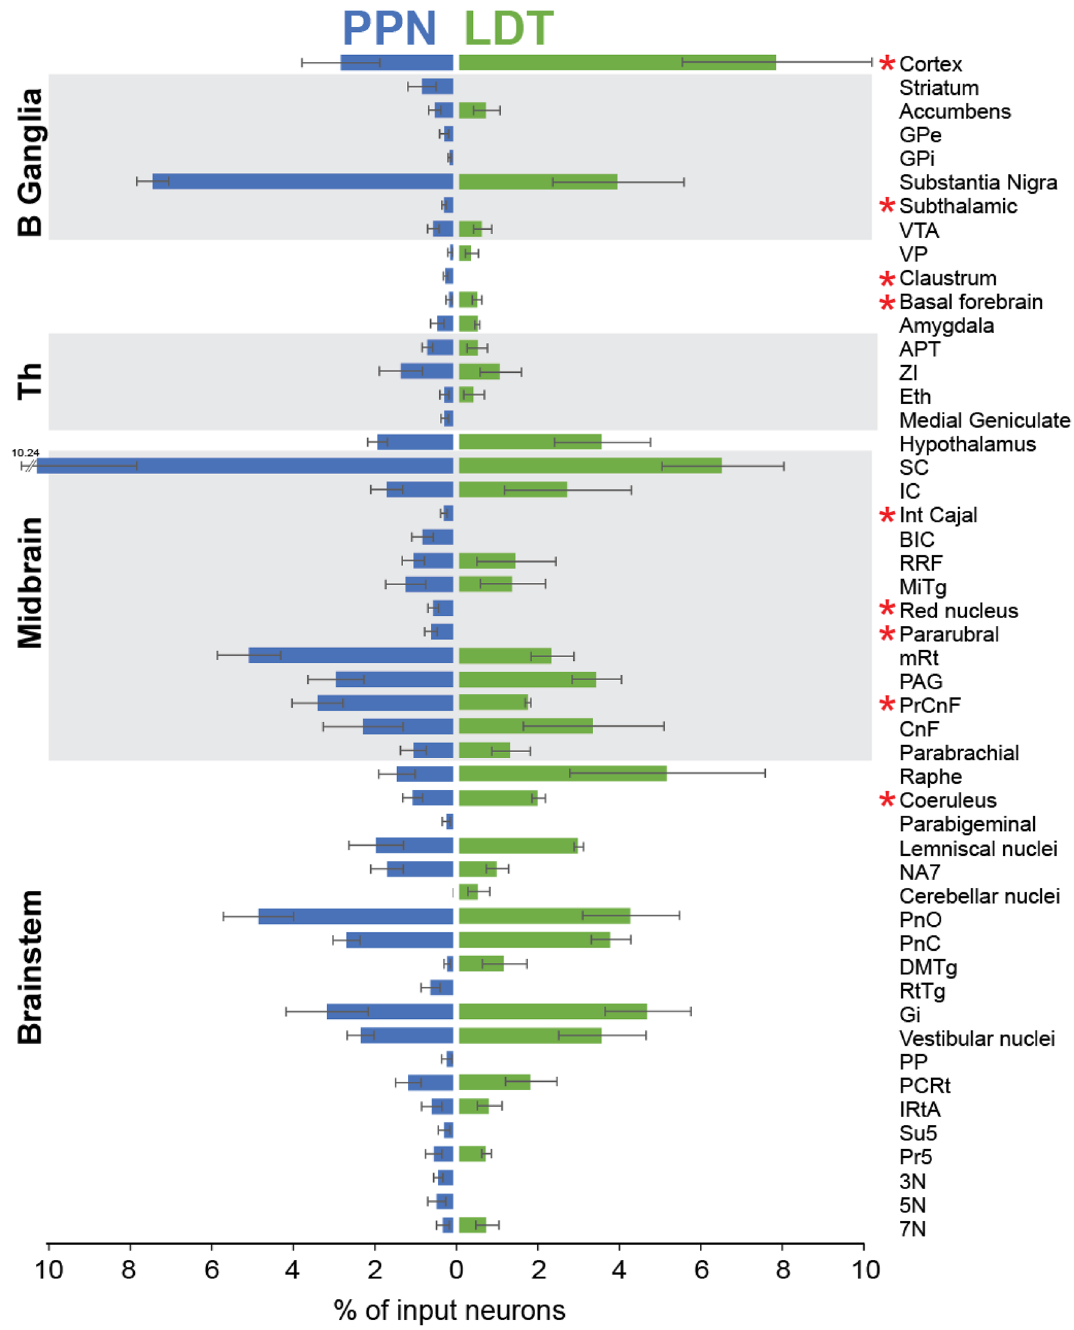
Figure 3. Major input structures to the cholinergic neurons of the PPN and LDT. Histogram showing the percentage of eGFP + input (transsynaptically-labeled) neurons after injections of modified rabies virus in the PPN and LDT. The percentage is normalized by the total number of input neurons and the structures were organized in functional areas. Two-sided t tests were used to compare differences between the number of input neurons to the PPN and LDT from all structures (*P ≤ 0.05). Mean ± SEM (PPN n = 6 rats; LDT n = 3 rats). See list of abbreviations in Table Compared to the PPN-injected animals, LDT-injected animals showed half of the input neurons in the SN (3.855% ± 1.6; 62.66 ± 9.83 neurons), although the difference was not significant (P = 0.07). Similarly, the globus pallidus pars interna (GPi) and the subthalamic nucleus (STN) provide more input neurons to the PPN than the LDT (two-tailed t tests, GPi P = 0.086, STN P = 0.01). In contrast, the largest source of inputs to the LDT was the cerebral cortex (7.73% ± 2.31; 122 ± 24.9 neurons) and this is in stark contrast to the PPN (2.76 ± 0.95; 99.33 ± 22 neurons; two-tailed t test P = 0.047). Another important input region to the LDT was the raphe (5.05% ± 2.38, 86 ± 34 neurons), which included the dorsal raphe (DR), with its ventral and dorsal segments, and the median